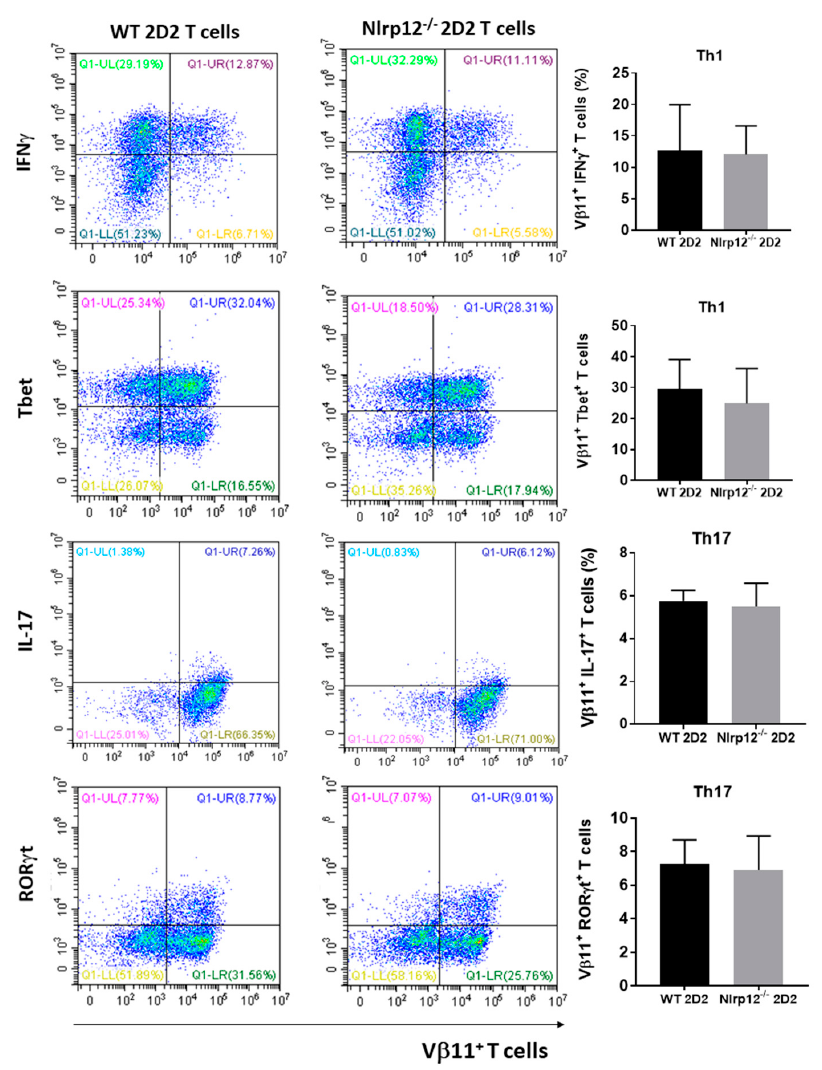
Figure 3. Nlrp12 does not affect the differentiation of naïve CD4 + T cells to Th1 or Th17. Naïve CD4 + T cells from WT and Nlrp12 − / − mice were purified and stimulated with MOG-splenocytes in the presence of Th1 or Th17 polarizing cytokines for 3 days. After 5 h stimulation with PMA/ionomycin, cells were stained for V β 11 and Th1- or Th17- associated cytokine/transcription factor and analyzed by flow cytometry, n = 3; Representative flow cytometric plots show the expression of Th1- and Th17-related markers in V β 11 + T cells.